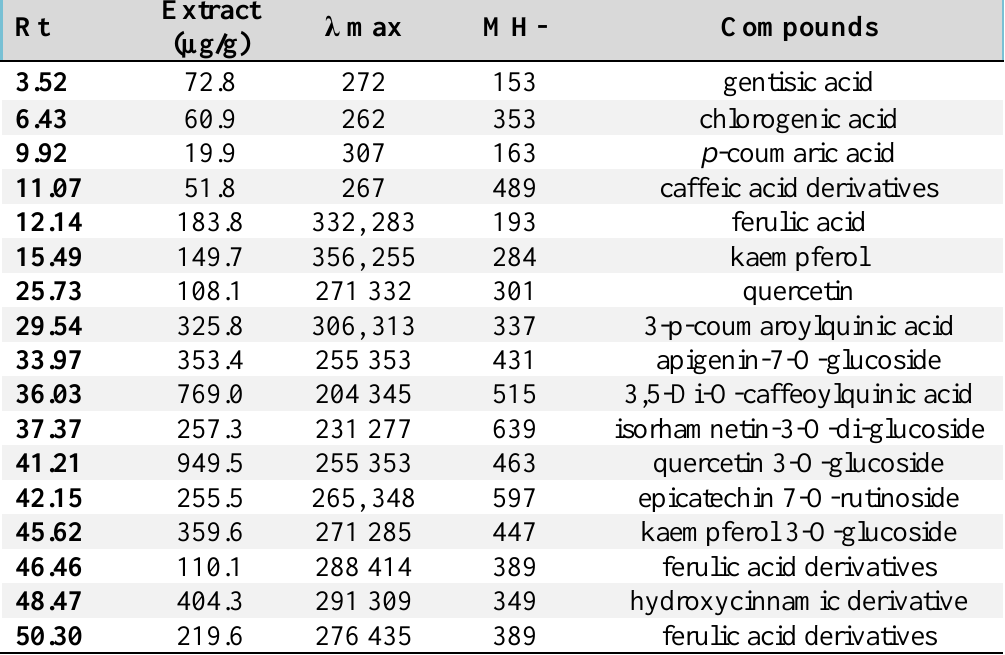
Table 2. HPLC-DAD-MS identification of phenolic compounds in Adiantum capillus-veneris hydromethanolic